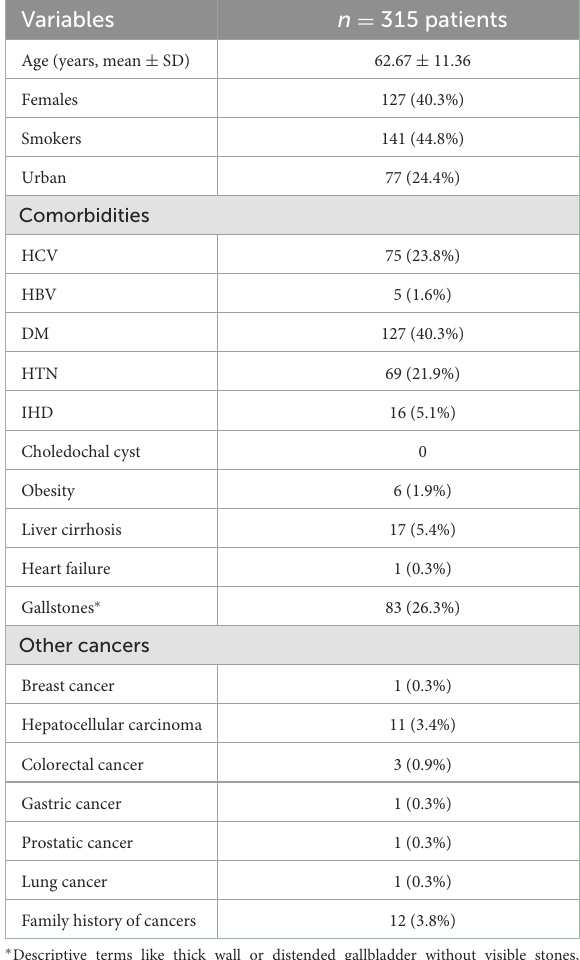
TABLE 1 Demographic data of the included patients; data are presented as numbers and